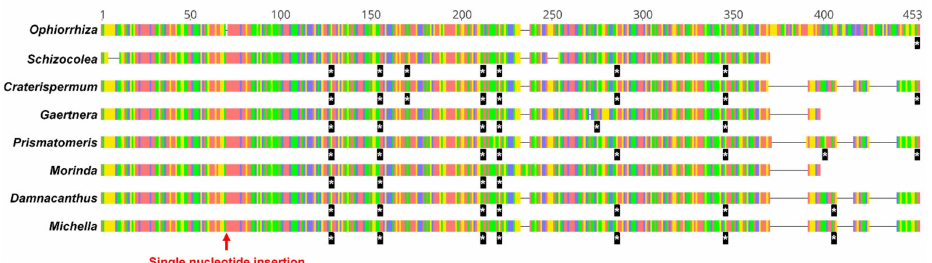
Figure 4. The alignment of rps7 sequences with a signal of pseudogenization. The sequence of Ophiorrhiza mungos is used as a reference. Horizontal lines with four kinds of colors are nucleotides (red = A, green = T, yellow = G, blue = C). Blacklines between nucleotides represent gaps in the alignment. The position of a single nucleotide (A) insertion is marked with a red arrow. The stop codons are presented below each of the nucleotide sequences as a black bar with an asterisk. Omitted species epithets are available in Figure 3.